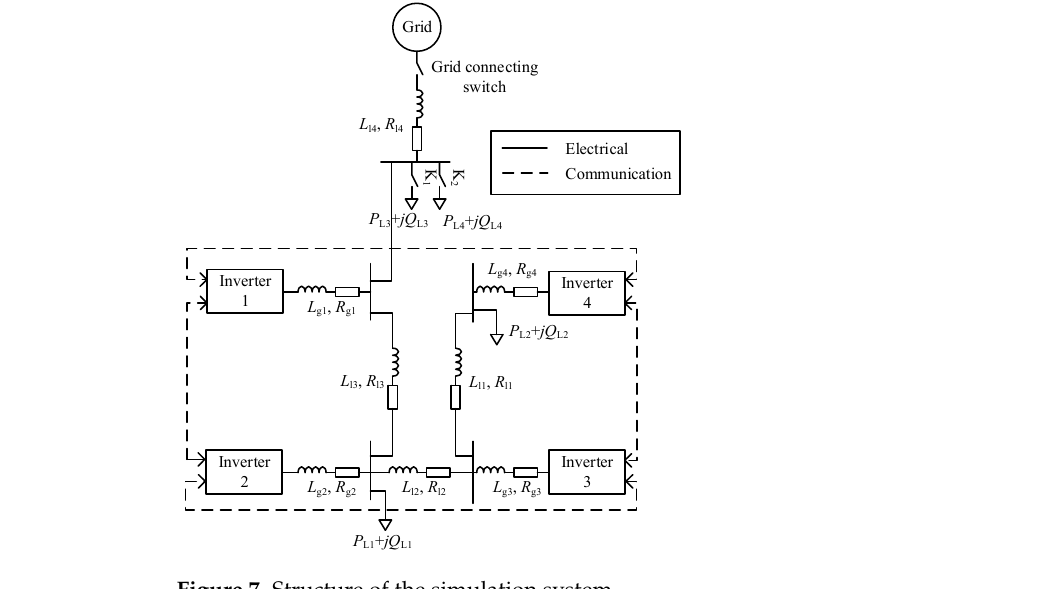
Figure 7. Structure of the simulation system. Table 3. Network parameters of microgrid.